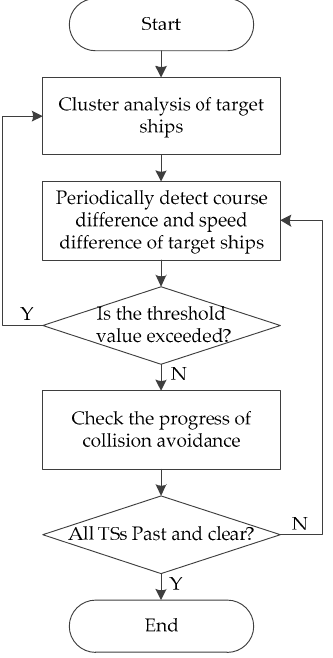
Figure 1. Samples of the group ship.